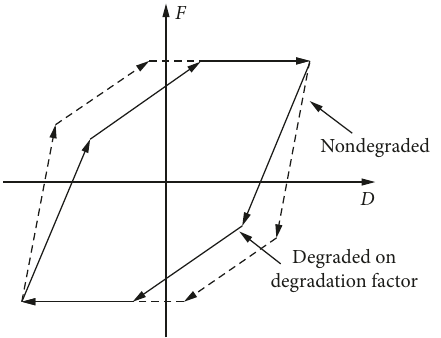
Figure 7: Hysteretic loop of energy degradation.